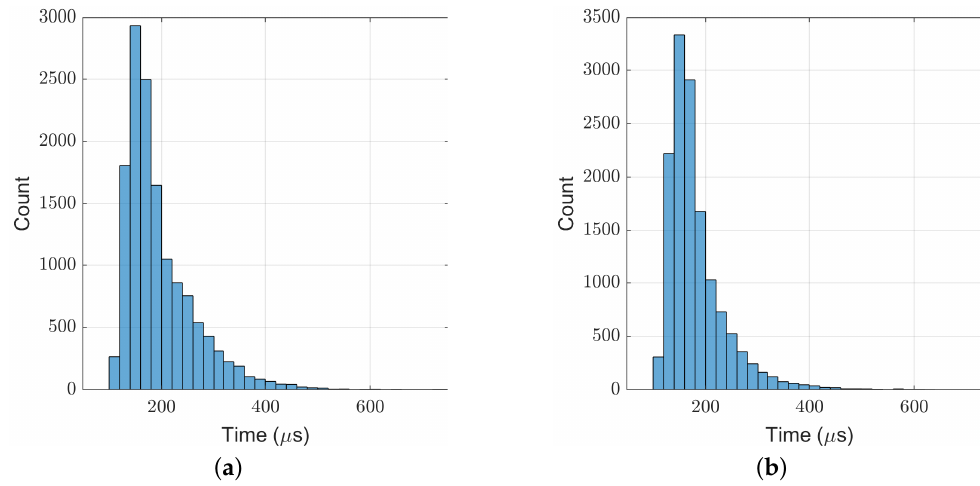
Figure 19. Computation time cost of TP-MPC in the side impact test. ( a ) 2.7 kg ball; ( b ) 3.2 kg